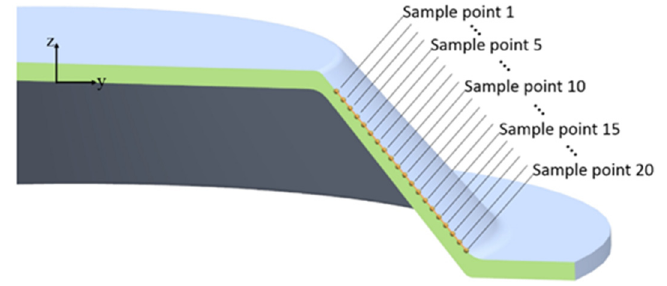
Figure 7. Distribution of sampling points for straightness calculation.